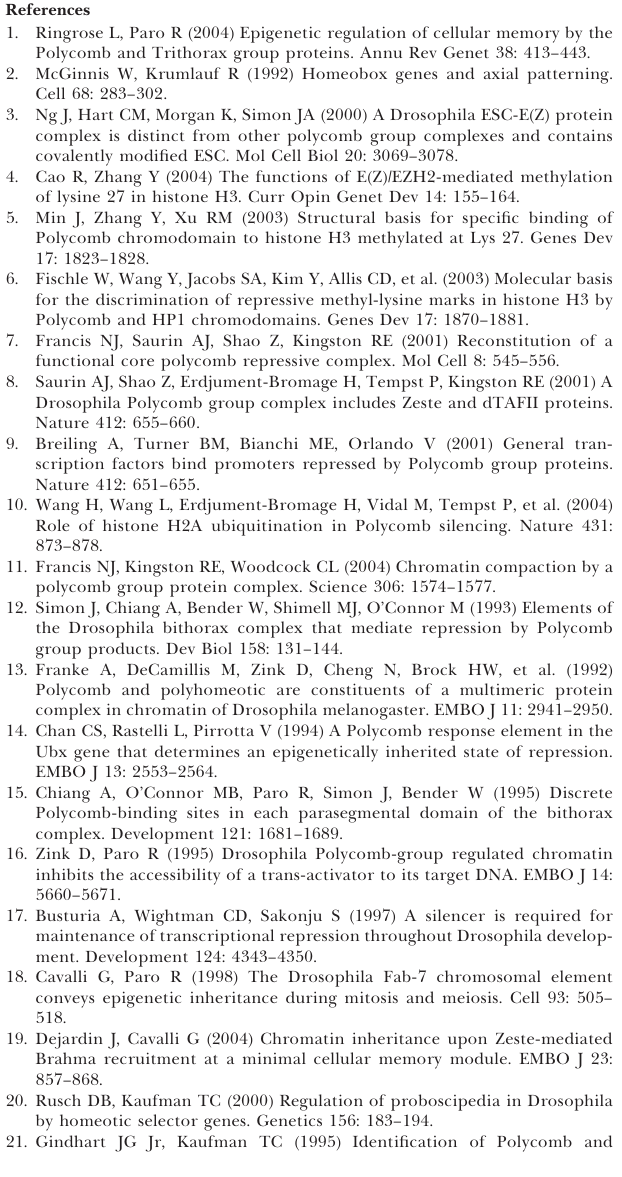
Table S15. Raw Data from Hybridization of MY Arrays Table S16. Raw Data from Hybridization of MY Arrays Table S17. Raw Data from Hybridization of MY Arrays Found at DOI: 10.1371/journal.pbio.0040170.st017 (14 MB XLS). Table S18. Raw Data from Hybridization of MY Arrays Table S19. Raw Data from Hybridization of MY Arrays Found at DOI: 10.1371/journal.pbio.0040170.st019 (13 MB XLS). Table S20. Raw Data from Hybridization of MY Arrays Found at DOI: 10.1371/journal.pbio.0040170.st020 (13 MB